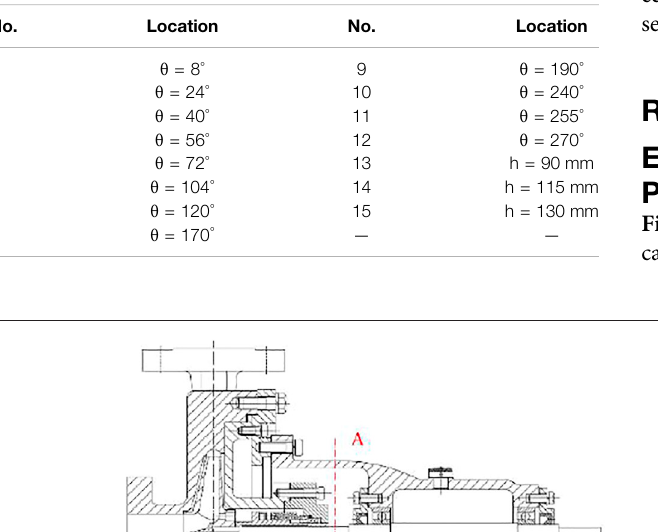
TABLE 2 | Installation position of the pressure sensor.